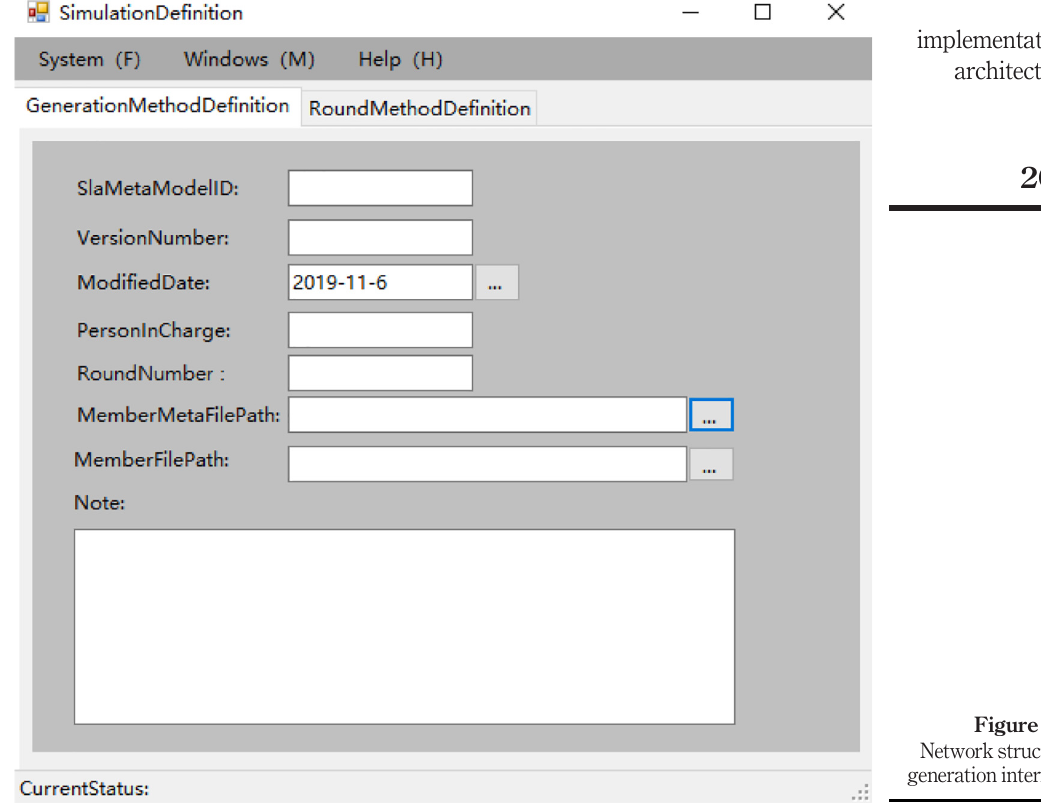
Figure 13. Network structure generation